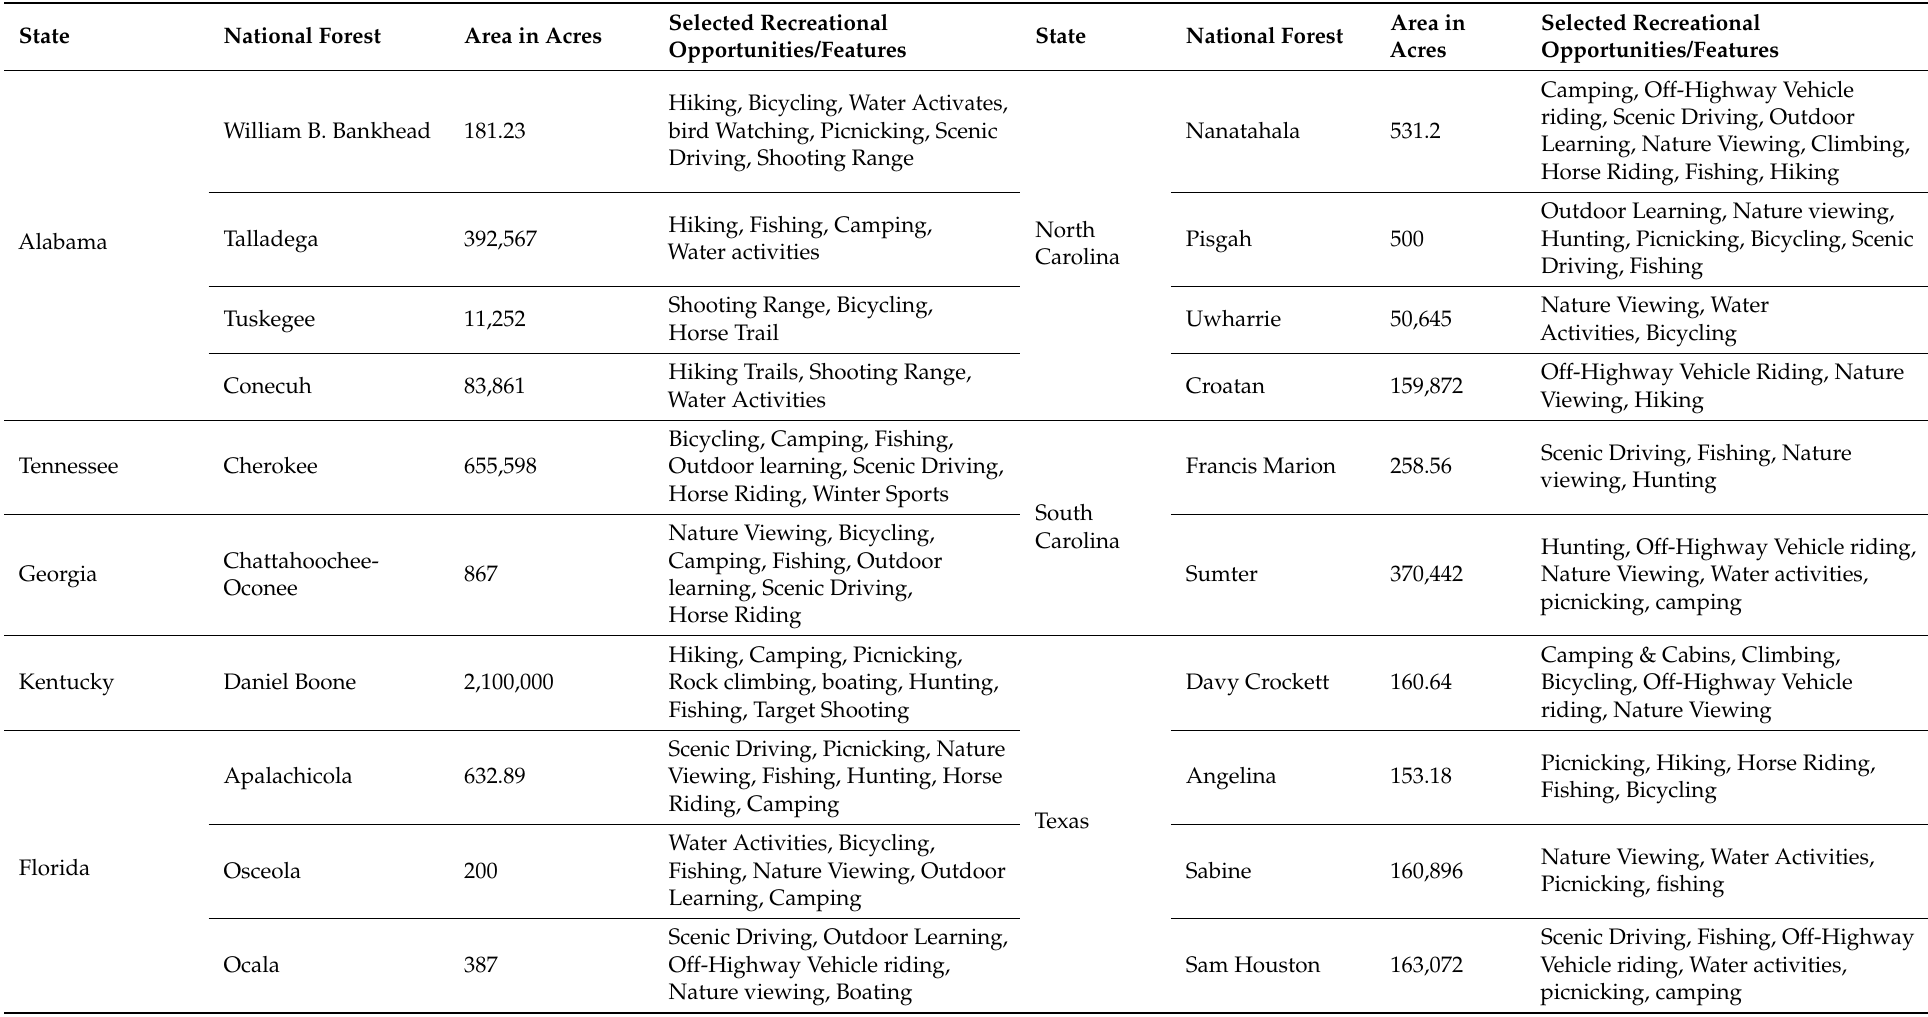
Table 1. Matrix of National Forests in the Southeast United States of